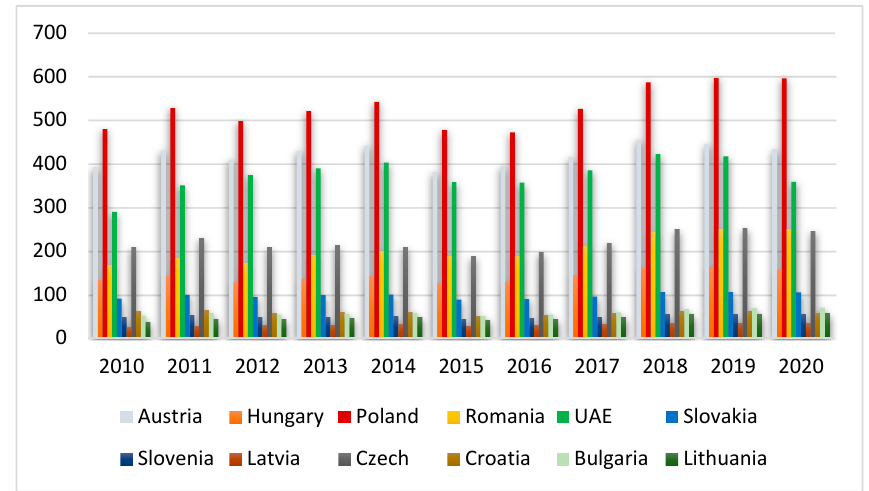
Figure 3. GDP in USD billion. Based on the World Bank data [17].